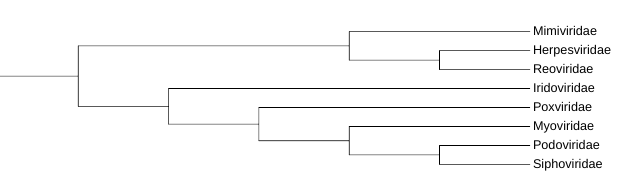
Figure 2. Phylogenetic tree of eight virus families by NJ method: Reoviridae , Herpesviridae , Mimiviridae , Iridoviridae , Poxviridae , Myoviridae , Siphoviridae , Podoviridae